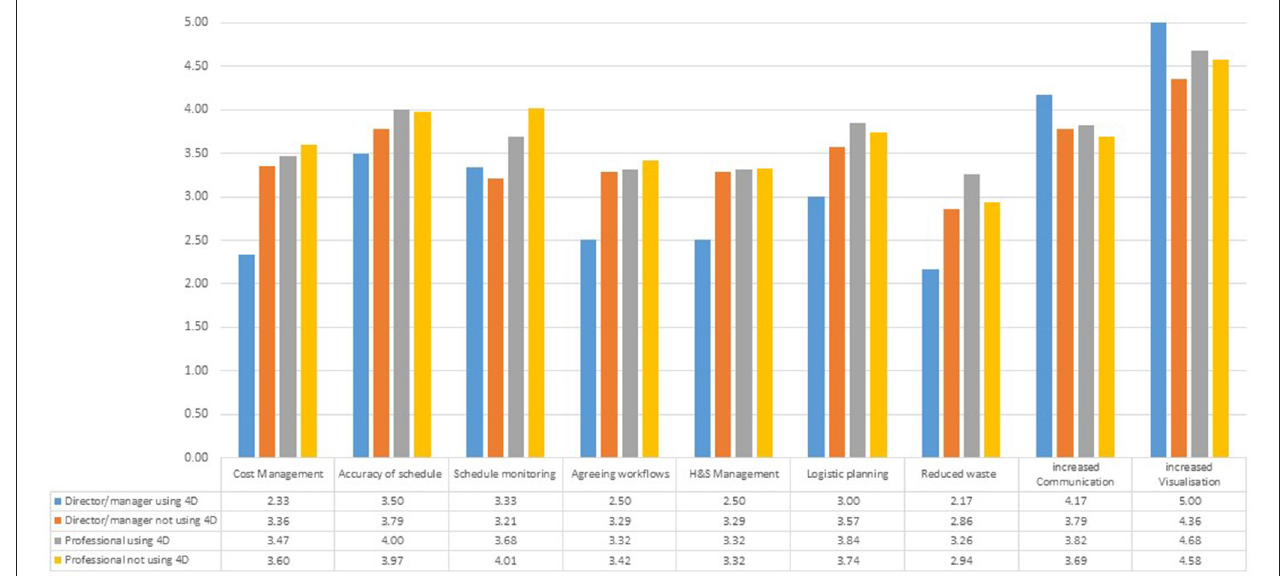
FIGURE 1 | Benefits of 4D modeling for construction site safety.